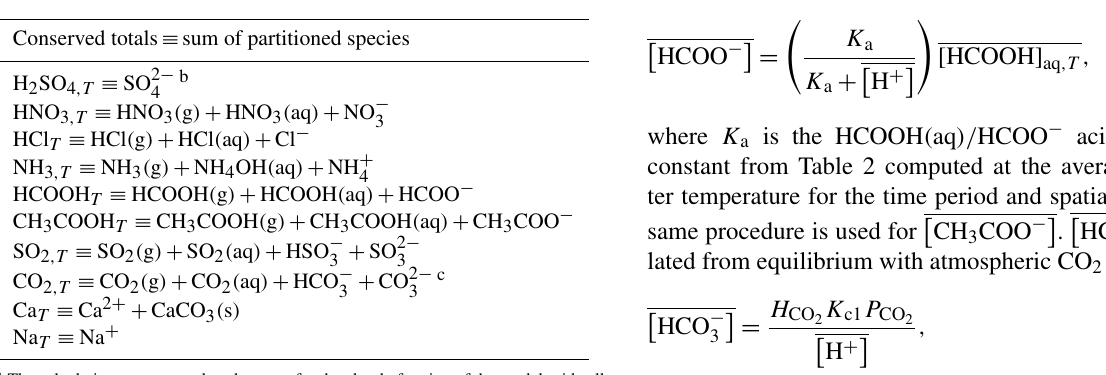
Table 3. Species included in the cloud water pH calculation a